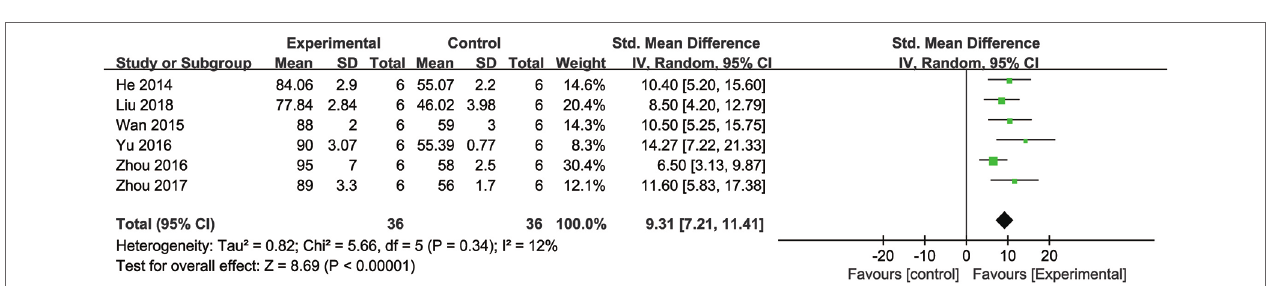
FIGURe 3 | The forest plot: (A) effects of notoginsenoside R1 for reducing the myocardial infarction size compared with the control group (n = 30 per group). (B) Effects of notoginsenoside R1 for reducing the creatine kinase compared with the control group (n = 16 per group). (C) The forest plot: effects of notoginsenoside R1 for reducing cardiomyocytes apoptosis rate compared with the control group (n = 24 per group).